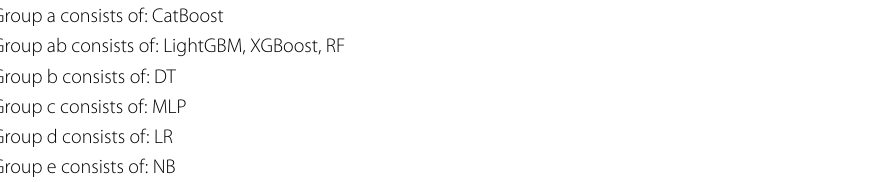
Table 24 HSD test groupings after ANOVA of AUC for the classifier